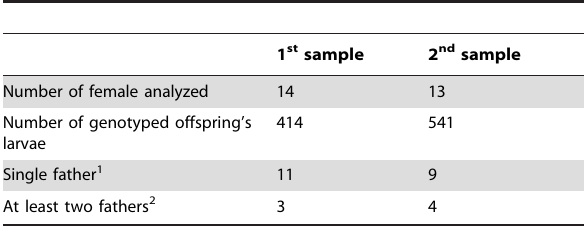
Table 2. Number of multiple inseminations in 27 female Aedes albopictus from La Reunion